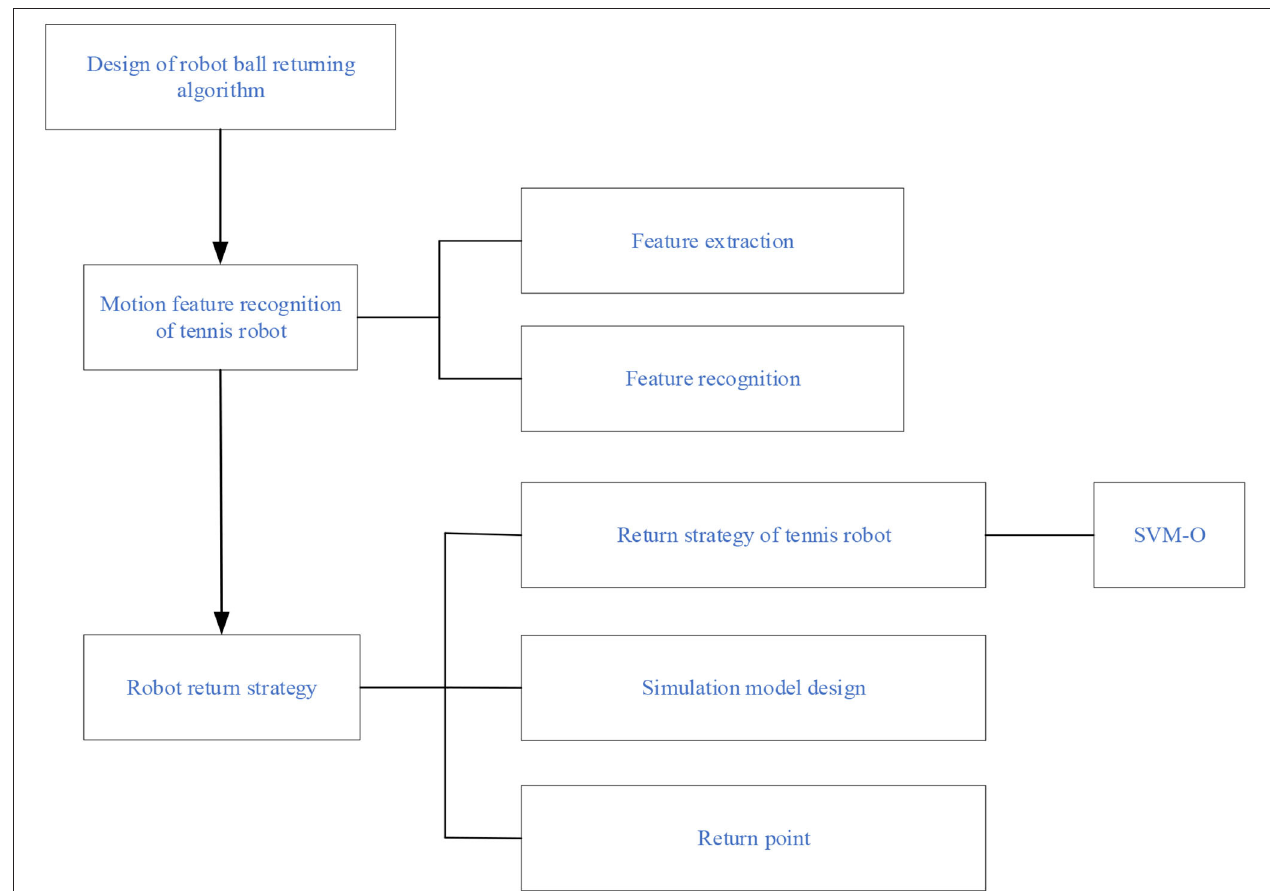
FIGURE 8 | Implementation framework of the return strategy of the tennis sports